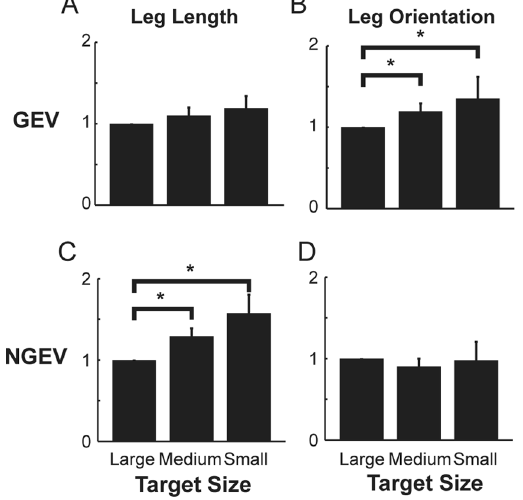
Figure 2. Variance components as a function of target size. Goal equivalent variance (GEV) and non-goal equivalent variance (NGEV) normalized to large target condition for the three target conditions for (a & c) leg length and (b & d) leg orientation. Bars are the averaged total variances for all subjects with 6 1 standard deviation. Leg length NGEV and leg orientation GEV increased for medium and small target condition relative to large target condition. *denotes significant difference (p ,